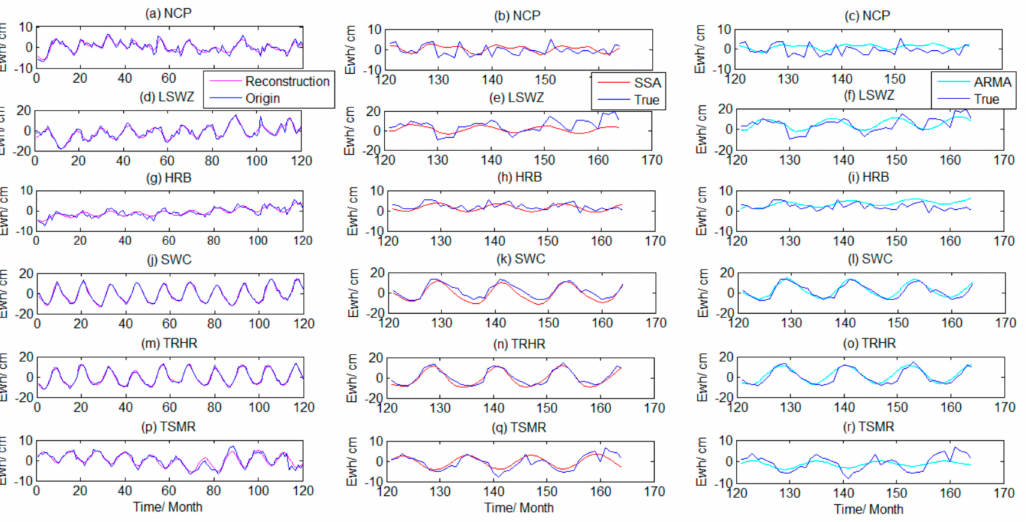
Figure 5. Singular spectrum analysis (SSA) reconstruction and the prediction time series from SSA and auto-regressive and moving average model